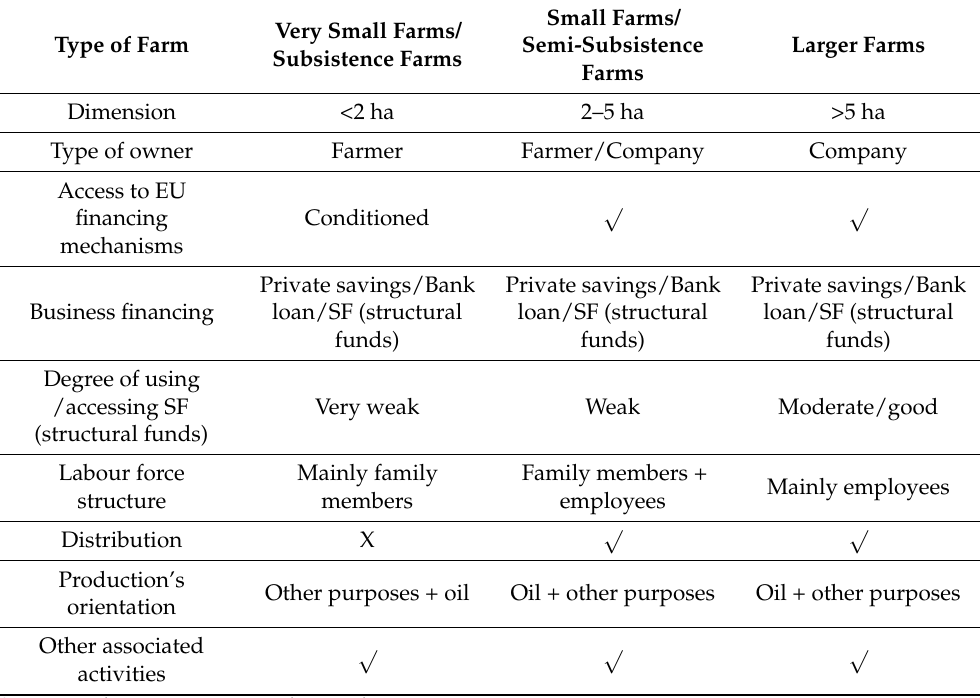
Table 2. Main types of lavender farming in Romania and associated elements. Very Small Type of Farm